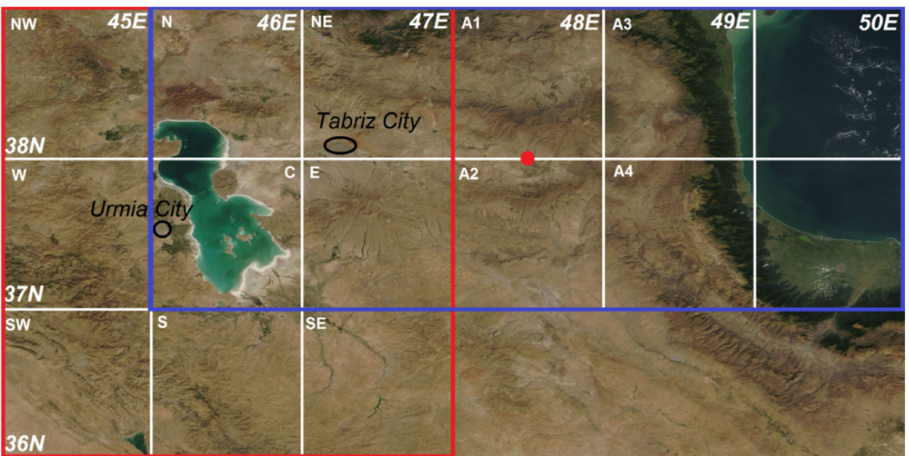
Figure 3. Snapshot of the Urmia Lake region (September 2003). Cells of 1 ◦ × 1 ◦ size are shown, used for extracting data series of NASA Aqua MODIS aerosol optical depth at 550 nm and Ångström exponent at 412/470 nm in 2002–2021. The red square delineates the cells of the Urmia Lake region. The blue rectangle delineates the cell of 5 ◦ × 2 ◦ size of monthly CALIPSO aerosol extinction coefficient at 532 nm profile. The red dot is the nodal point of the cell’s monthly CALIPSO aerosol profiles. For this cell (centered at 38 ◦ N, 47.5 ◦ E, marked with a red dot in Figure 3), all monthly average tropospheric profiles of the total aerosol were extracted, from which seasonal profiles were calculated for the entire period 2006–2021, as well as monthly mean tropo- spheric aerosol optical depths of the total aerosol at a wavelength of 532 nm (AOD 532 ), were reconstructed. ∑ ε × 0.06 AOD 532 = i